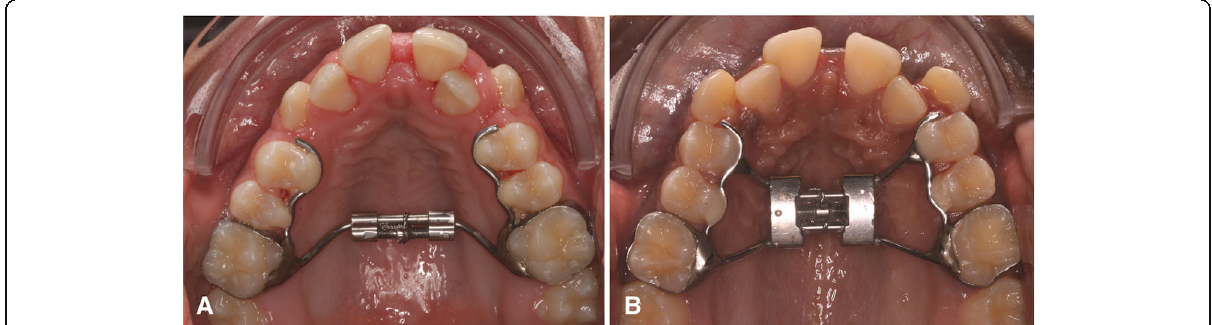
Fig. 1 Expander appliances: A . Mini Hyrax; B .